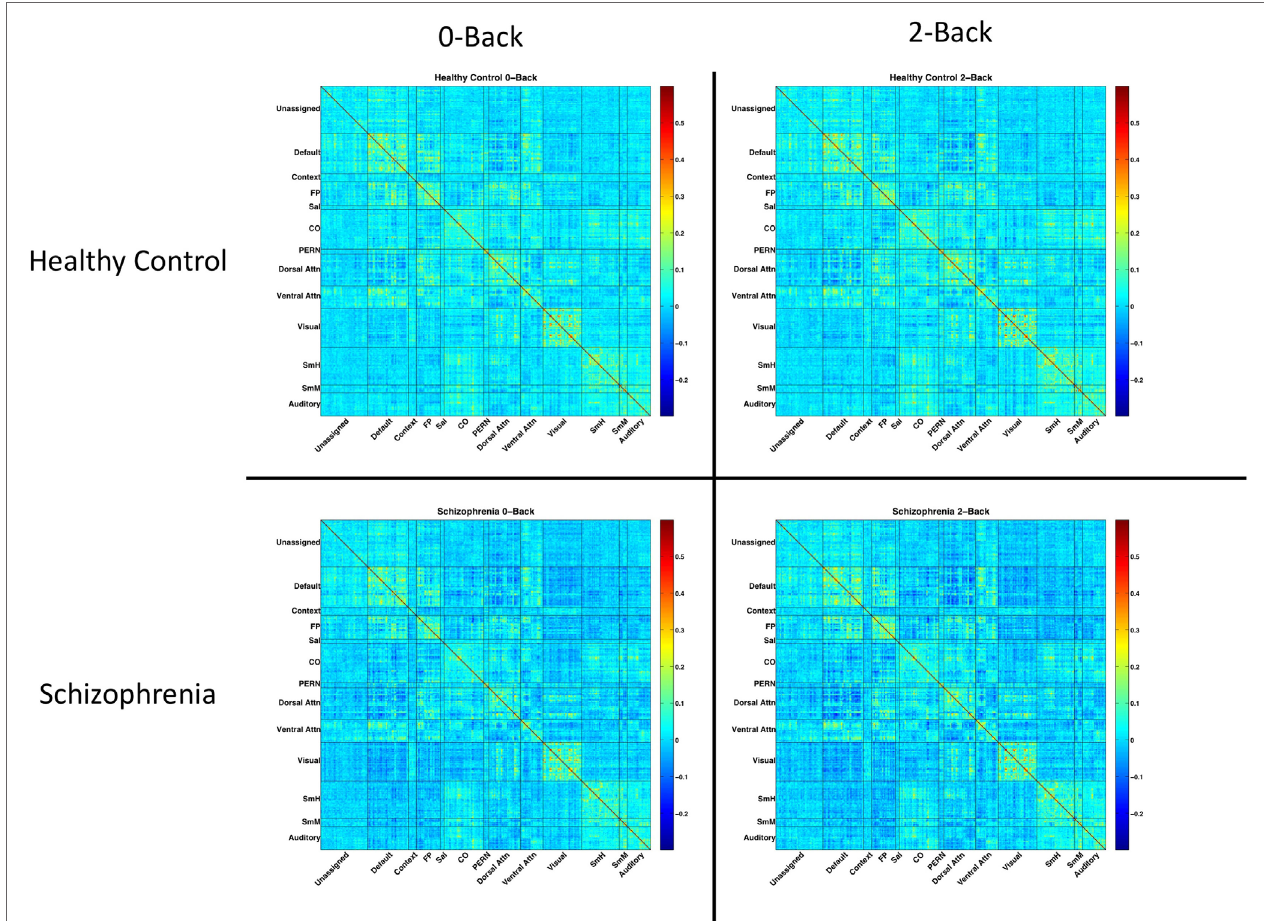
FigUre 1 | Network matrices for each diagnostic group and n -back condition. Each matrix is averaged across all relevant subjects and organized based on a 333-node boundary-map parcelation, detailed in Gordon et al. (27). Warmer colors indicate stronger connections. Cooler colors indicate weaker